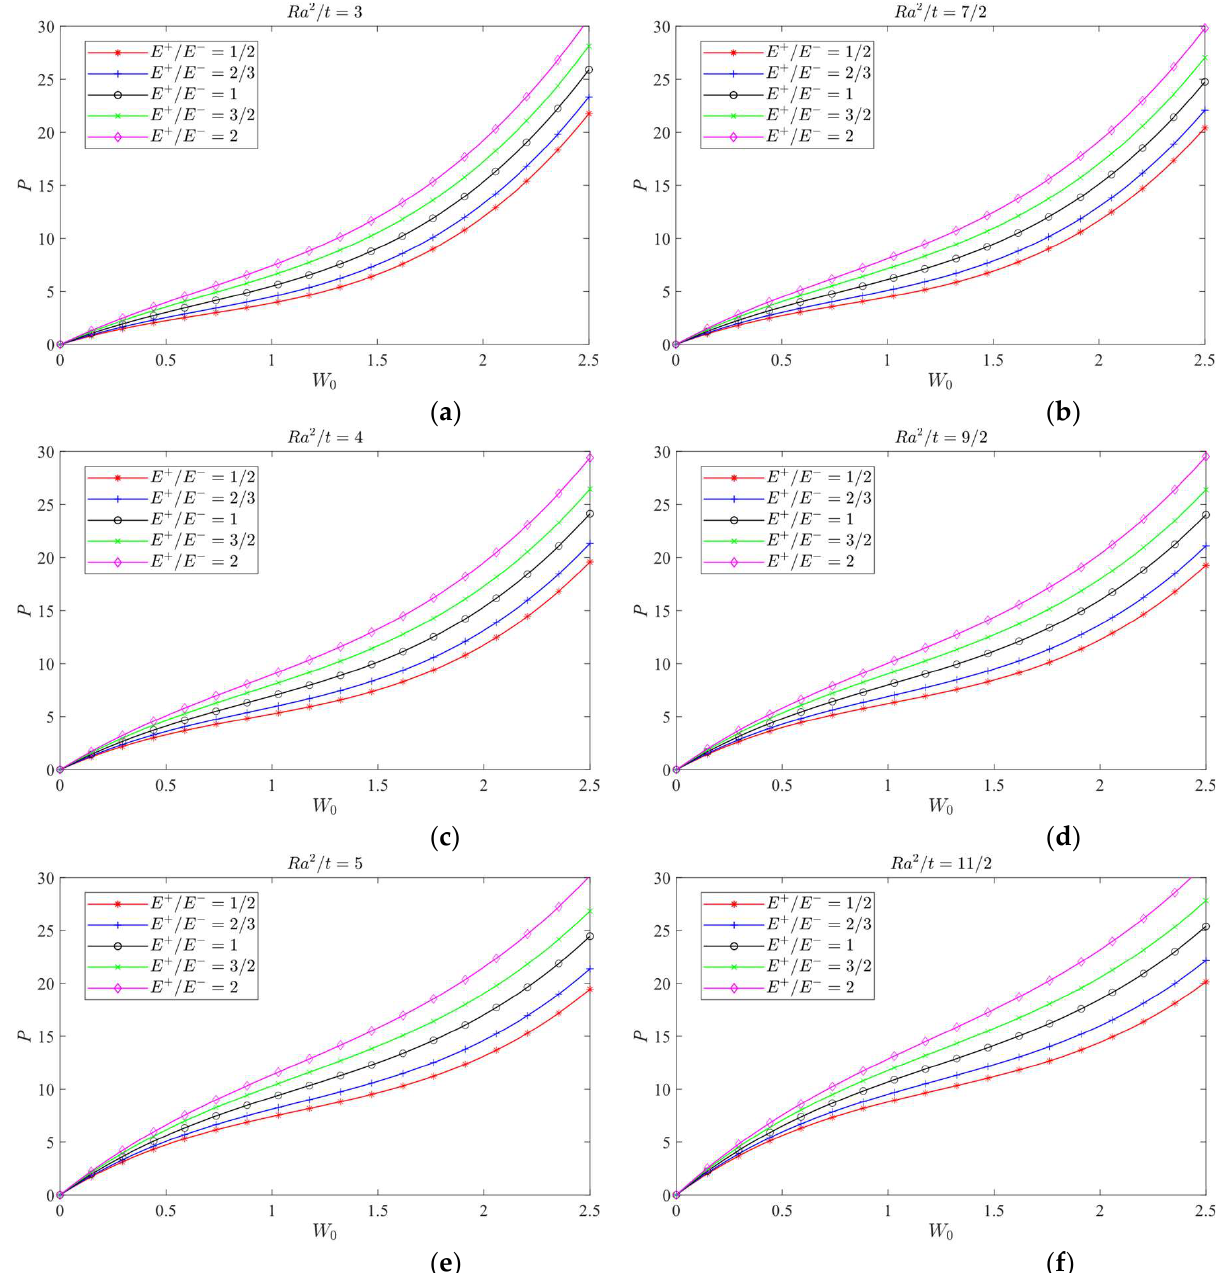
Figure 12. Load vs. central deflection when λ = 1. ( a ) Ra 2 / t = 3; ( b ) Ra 2 / t = 7/2; ( c ) Ra 2 / t = 4; ( d ) Ra 2 / t = 9/2; ( e ) Ra 2 / t = 5; ( f ) Ra 2 / t = 11/2.